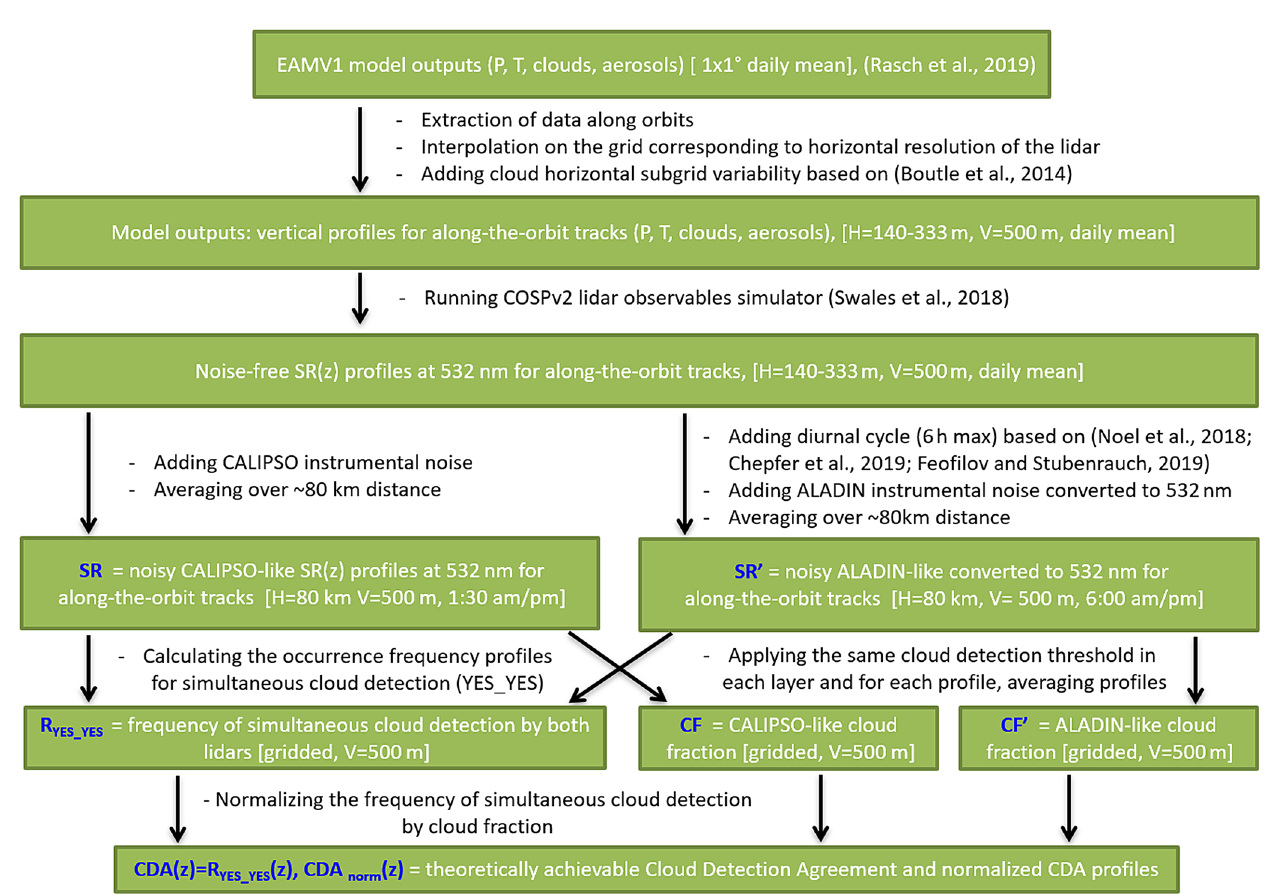
Figure 3. A flowchart explaining the numerical experiment on estimating the best possible cloud detection agreement for a combination of ALADIN and CALIOP observations. Green boxes list the input and output data. Black text between boxes describes actions performed on each dataset. Blue text in the boxes marks the datasets used in the estimation. White text in square brackets in the boxes indicates horizontal (H) and vertical (V) resolutions of the